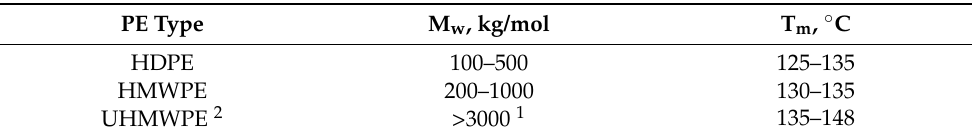
Table 1. Classification of linear polyethylene by its weight [11].